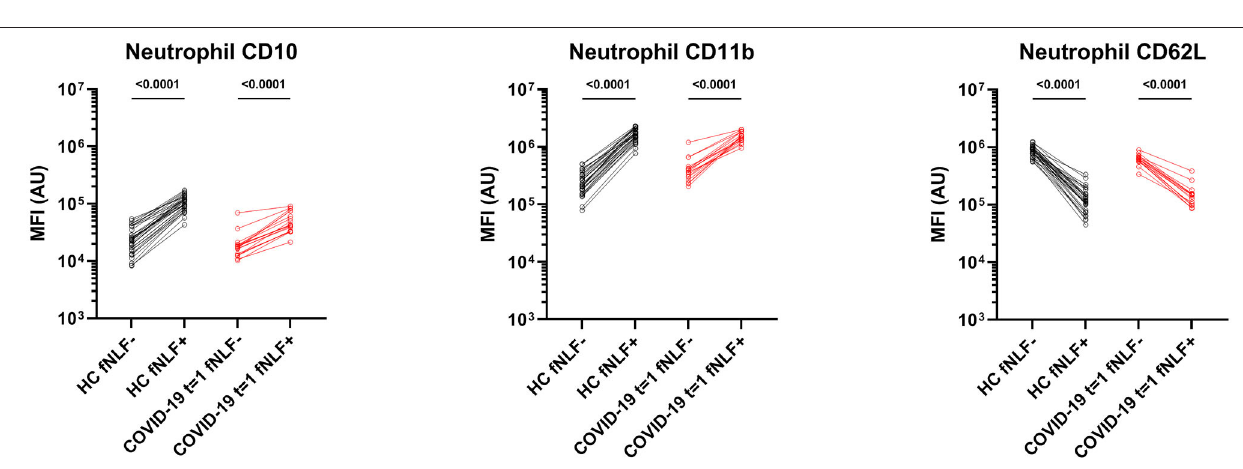
FIGURE 4 | Median fluorescence intensity (MFI) in arbitrary units (AU) for markers on mature neutrophils in healthy controls (HC) and in primary care patients with active COVID-19 disease ( t = 1). Paired analyses are shown for the samples measured in the absence (fNLF-) and presence (fNLF + ) of a formylpeptide (10 µ M). Statistical significance was tested using the Wilcoxon matched-pairs signed rank